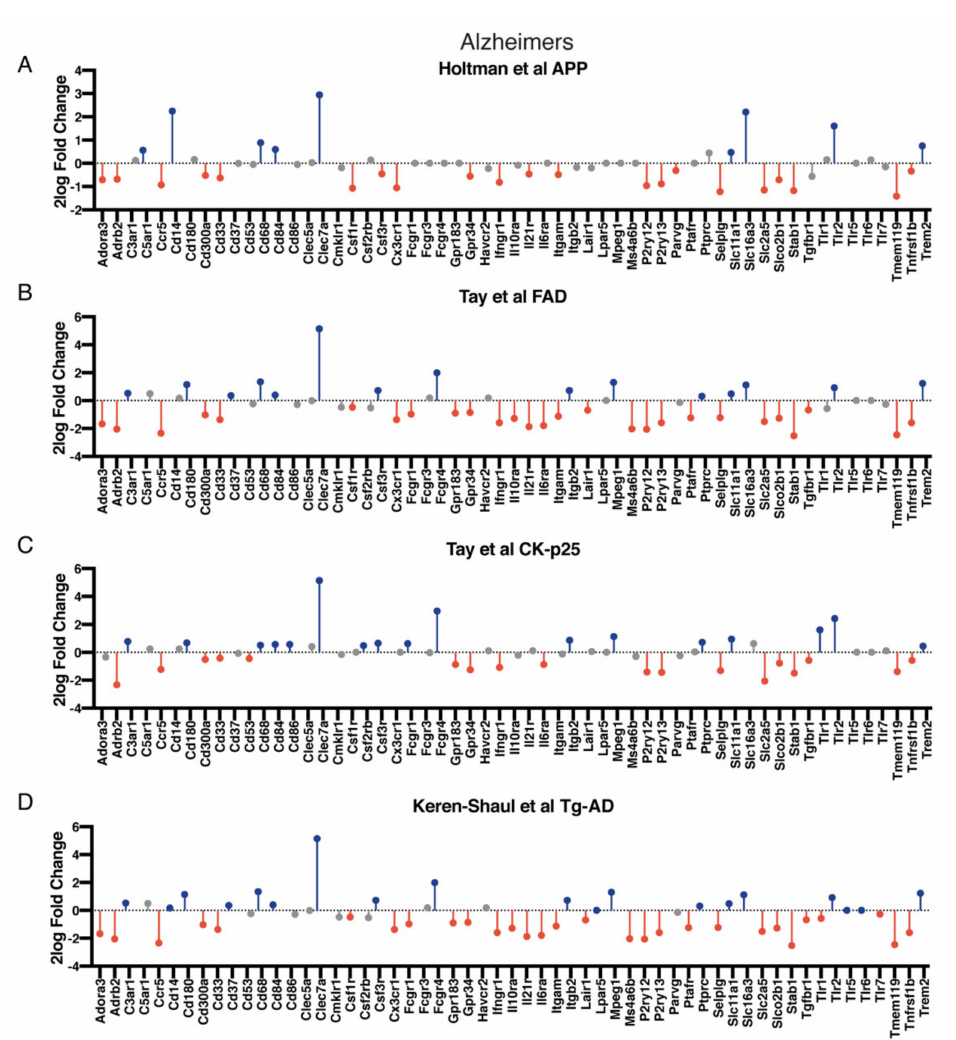
Figure 5. Microglia core sensome expression in Alzheimer’s disease (AD). ( A ) Two-log fold change of microglia core sensome genes in microglia in AD mouse model (APP) [12]. ( B ) Microglia core sensome gene expression in 5xFAD mouse model [13]. ( C ) CK-p25 mouse model gene expression of microglia showing changes in microglia core sensome [13]. ( D ) Differential gene expression analysis of single cell microglia data comparing homeostatic microglia versus disease-associated microglia (DAM) in an AD mouse model (Tg-AD) showing changes in microglia core sensome [4]. Red bars display gene significantly upregulated, blue bars represent gene significantly downregulated (detailed expression data in Supplementary Table